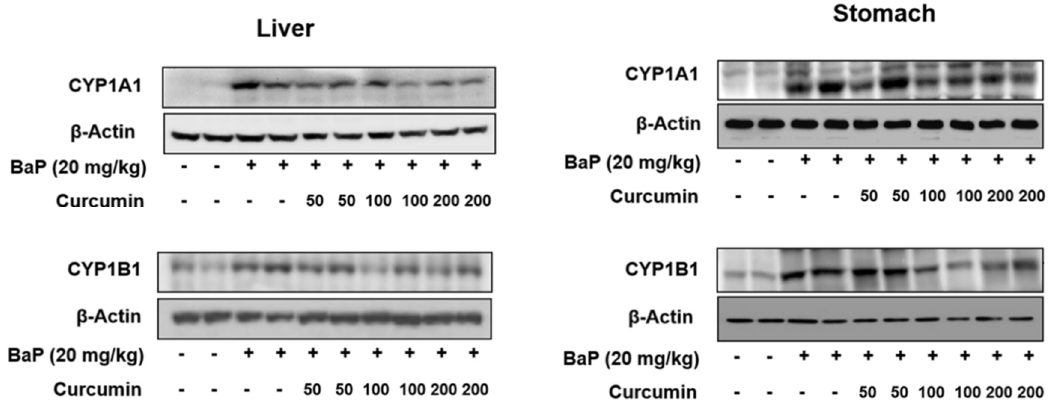
Figure 5. Effect of curcumin on the expression of cytochrome P450 (CYP)1A1 and CYP1B1 in liver and stomach of rats treated with benzo[a]pyrene (BaP). Rats were orally administrated BaP alone (20 mg/kg) or in combination with curcumin (50, 100, or 200 mg/kg) for 30 days. The control group was administered vehicle only. Representative bands of western blot for CYP1A1 and CYP1B1 were shown. β -Actin was used as endogenous control to normalize the data.